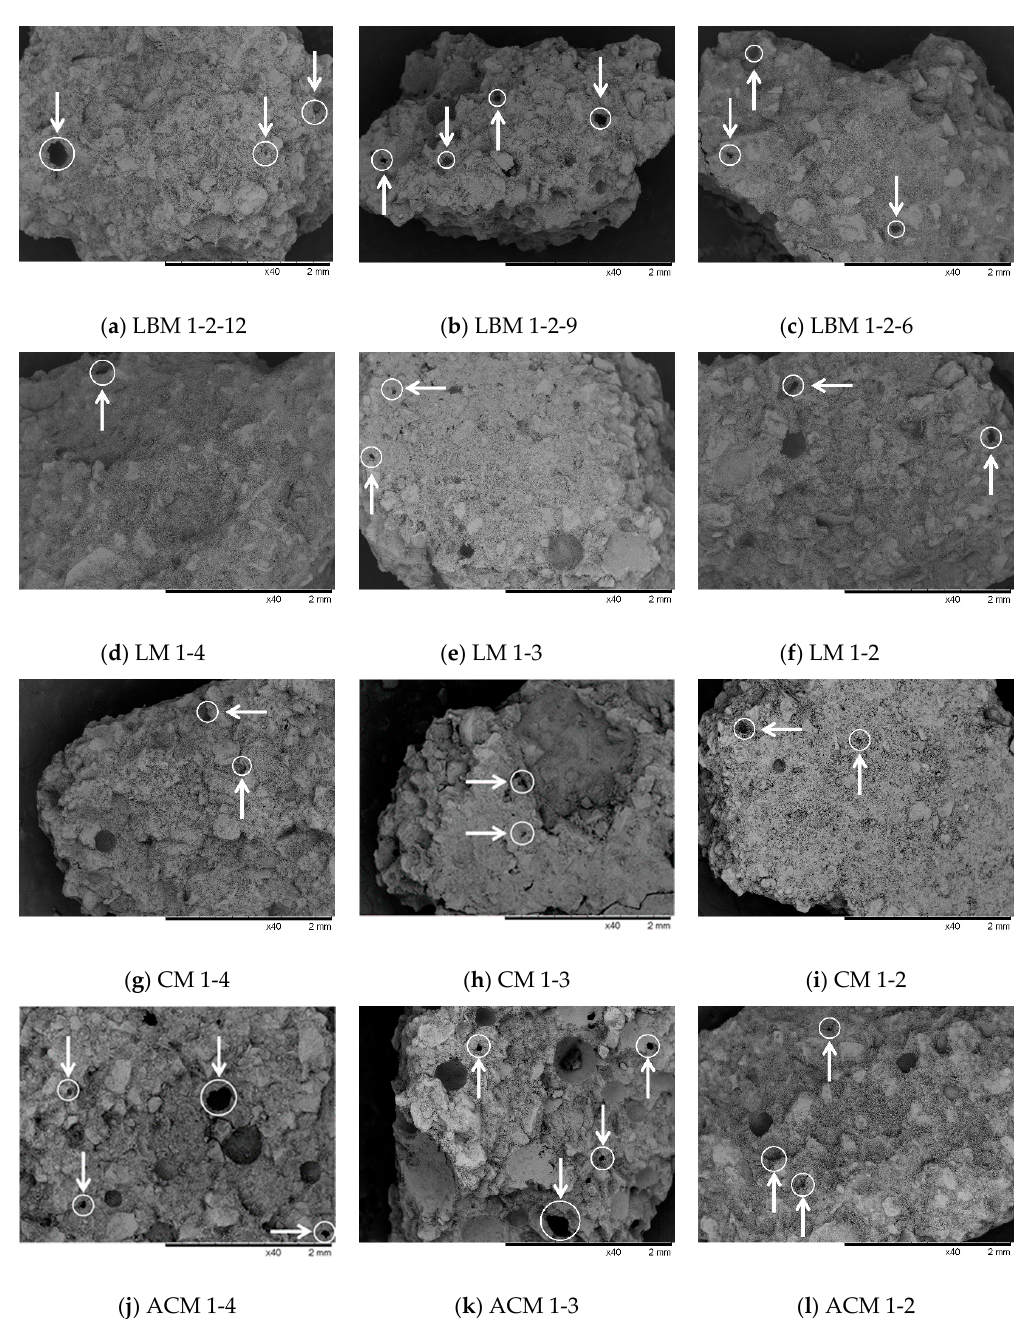
Figure 3. Characteristic SEM images of mortar samples recorded at × 40 magnification. ( a ) sample of mortar type LBM 1-2-12; ( b ) sample of mortar type LBM 1-2-9; ( c ) sample of mortar type LBM 1-2-6; ( d ) sample of mortar type LM 1-4; ( e ) sample of mortar type LM 1-3; ( f ) sample of mortar type LM 1-2; ( g ) sample of mortar type CM 1-4; ( h ) sample of mortar type CM 1-3; ( i ) sample of mortar type CM 1-2; ( j ) sample of mortar type ACM 1-4; ( k ) sample of mortar type ACM 1-3; ( l ) sample of mortar